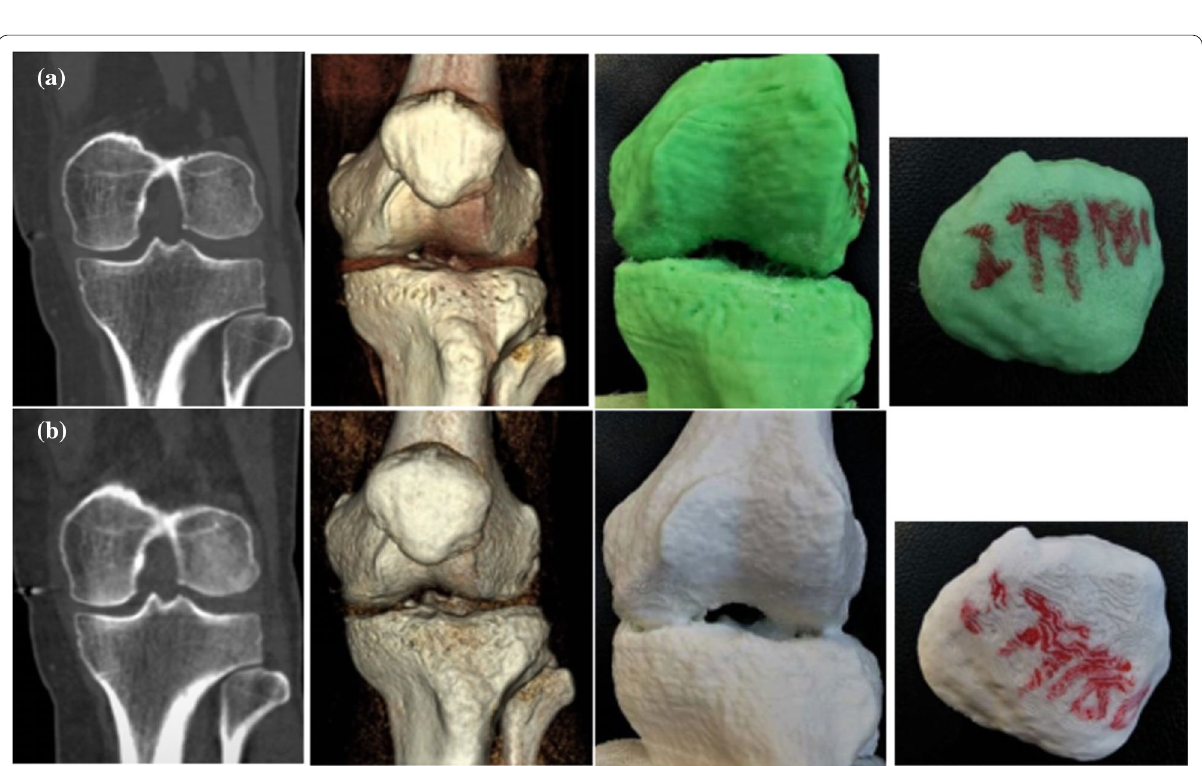
Fig. 1 Representative case study 1. A 62-year-old man with a suspected intercondylar ridge fracture underwent two scans (at the first visit and 7 days later). Standard-dose ( a ) and ultra-low-dose ( b ) protocols were used to generate three-dimensional printing models based on 3D CT data. Image quality and 3D printing model based on the former is better than the latter (3 vs. 2 points). The 3DP model is appropriate for preoperative